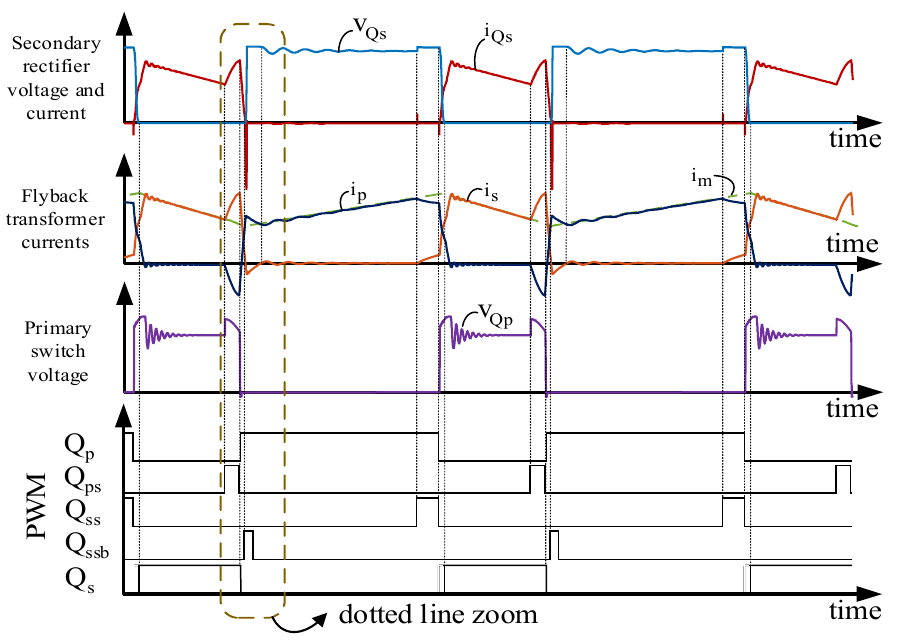
Figure 11. Timing waveform of the technique.